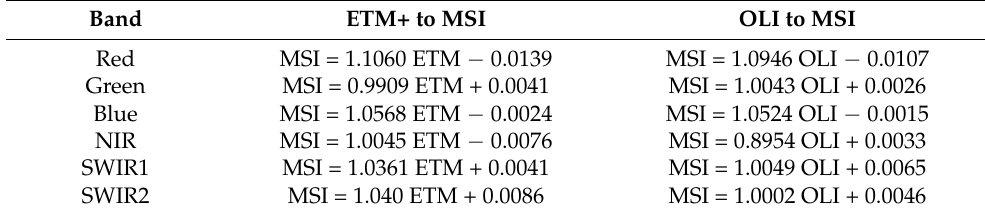
Table 3. The transformation formula from Landsat to